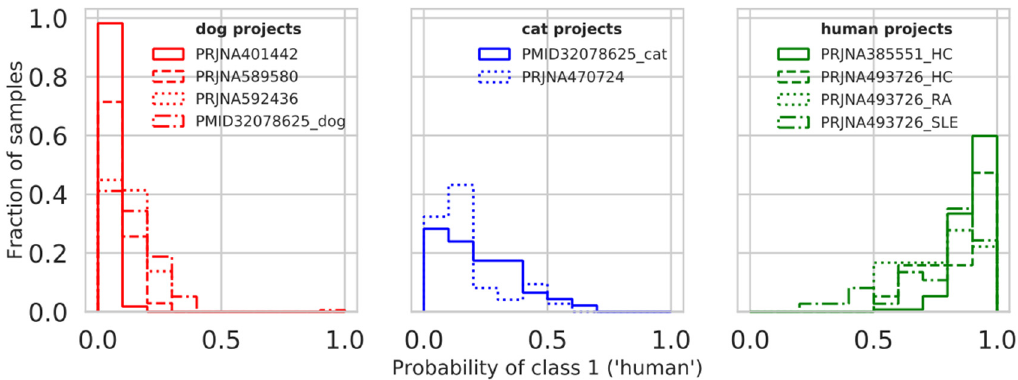
Figure 4. Prediction score distributions of the additional projects. The histograms for the probability of class 1 (‘human’) for the seven additional projects are present. The dog projects are shown in red, cat projects in blue, and human projects are in green. Specific projects are shown with the combination of color and linetype (see the in-graph legend). Table 4. Genus_MW-FDR performance on a mixed class dataset.